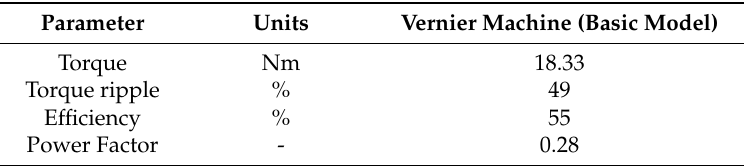
Table 2. Performance of the basic model of the BL-WRVM.